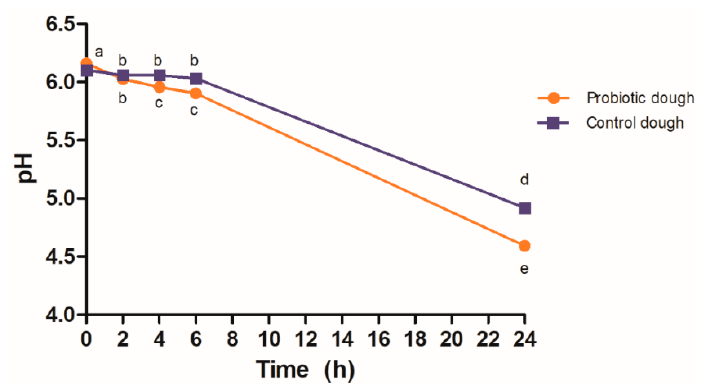
Figure 1. pH values for dough fermentation; data is mean ( ± standard deviation) of three replicates. a, Figure 1 . pH values for dough fermentation; data is mean (±standard deviation) of three replicates. a, b, c, d, e di ff erent letters indicate significant di ff erences ( p < b, c, d, e different letters indicate significant differences ( p < 0.05).